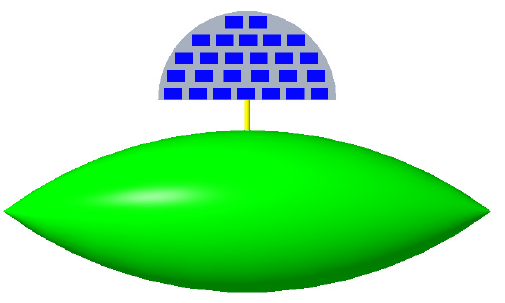
Figure 9. Three-dimensional model of the satellite after the deployment of the fan-shaped solar ar- ray.